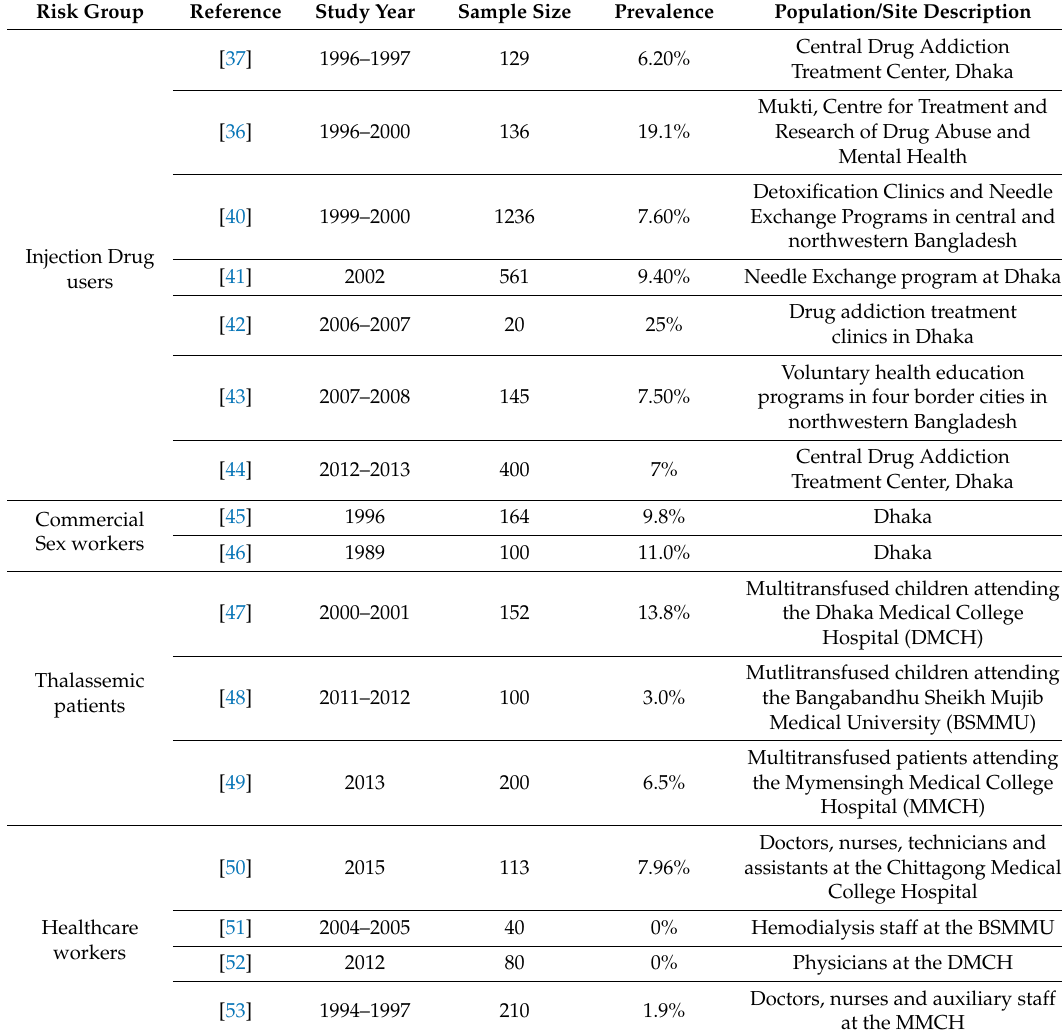
Table 1. Brief description of studies conducted on prevalence among important risk groups of HBV in